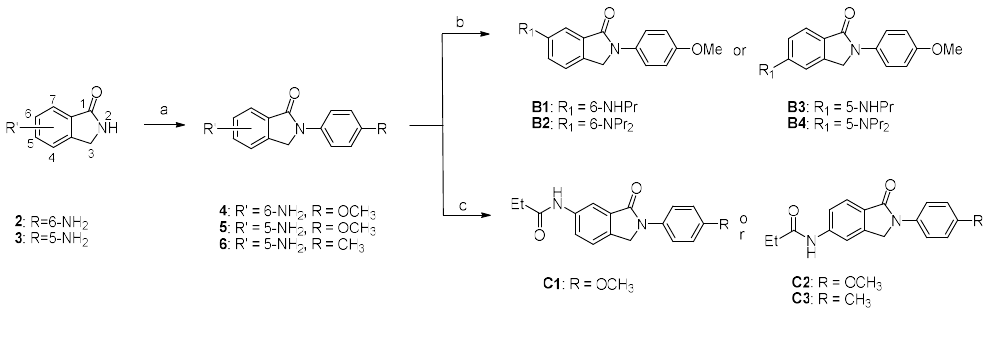
Scheme 2. Preparation of N -(4-carbamoyl)phenyl-isoindolin-1-ones.